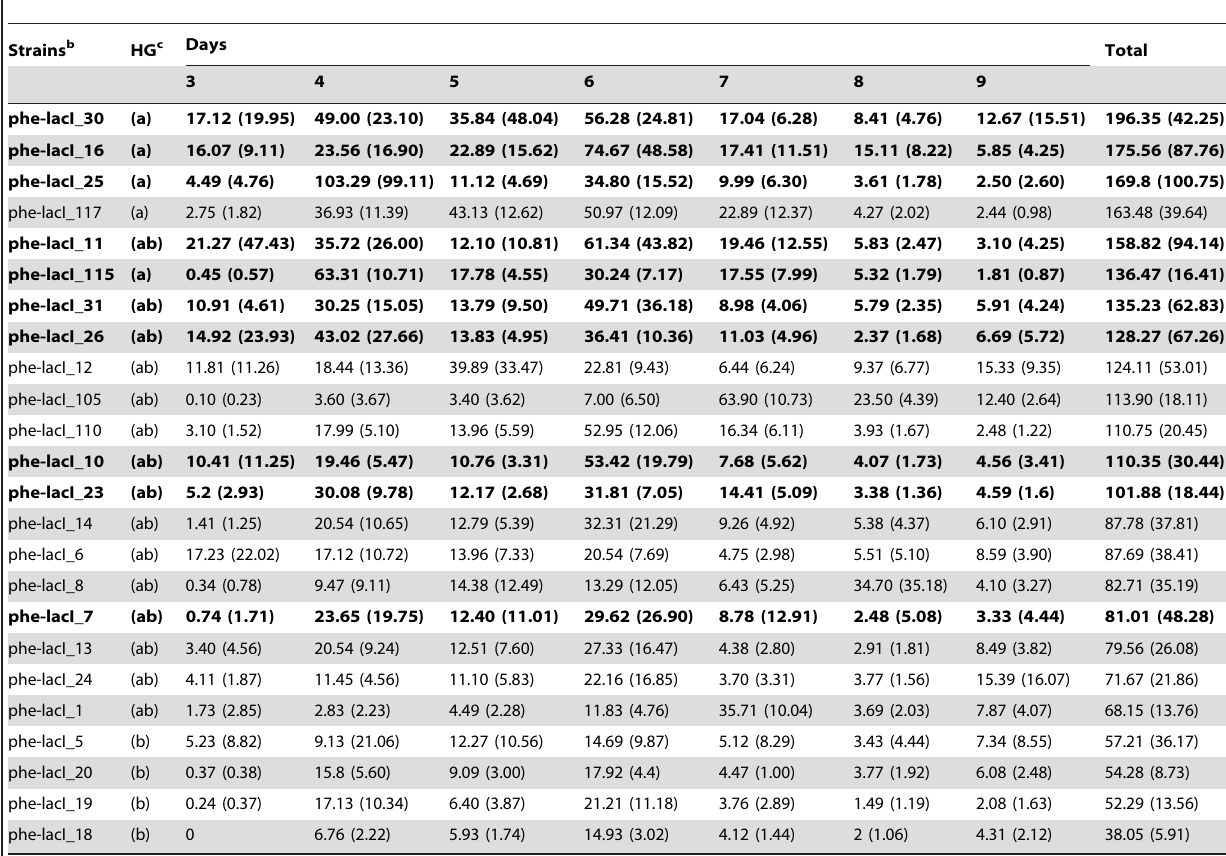
Table 1. The frequency of accumulation of Phe + mutants in P. putida strains carrying the phe-lacI test system at different chromosomal locations a